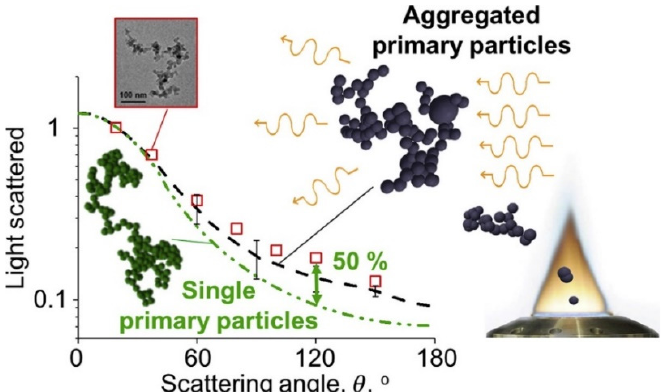
Figure 12. Functions of light scattering signal with scattering angle for single primary particles and aggregated primary particles [169]. Reproduced with permission from Kelesidis, G.A., et al., Powder Technology; published by Elsevier, 2020.